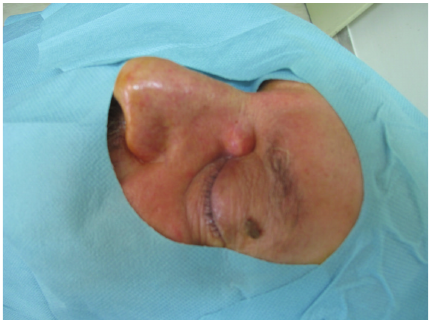
Figure 5: p63 myoepithelial cells × 200.